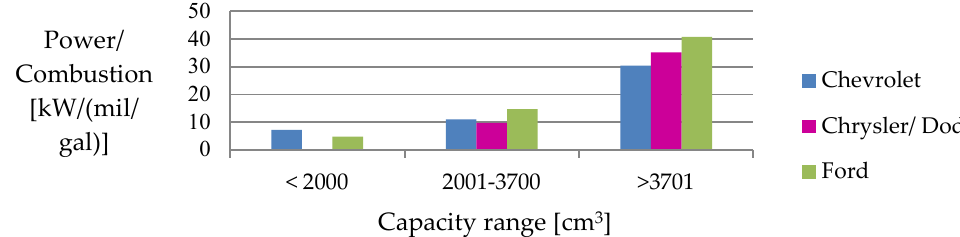
American car brands. Source: Developed own.